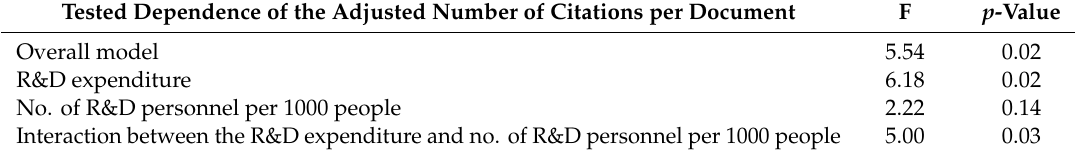
Table 2. Multiple regression analysis using the adjusted number of citations per document as a dependent variable and the R&D expenditure, no. of R&D personnel per 1000 people and their interaction as independent